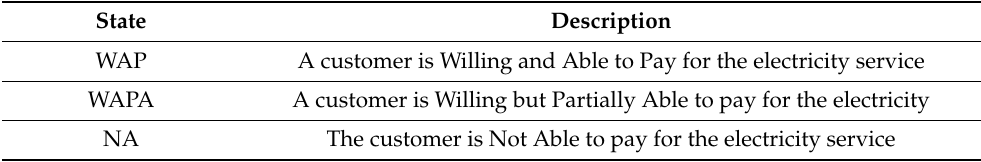
Table 1. State of the customers.